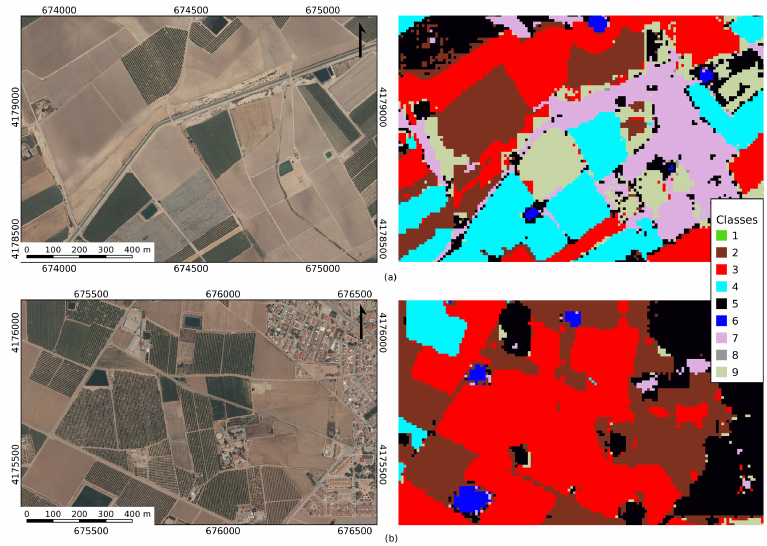
Figure 9. Issues with fallow fields in classification: Right: ( a ) example of classification as bare soil (class 7); ( b ) example of classification as scrub (class 2). Left: both areas areas in ortho-photography (2019).